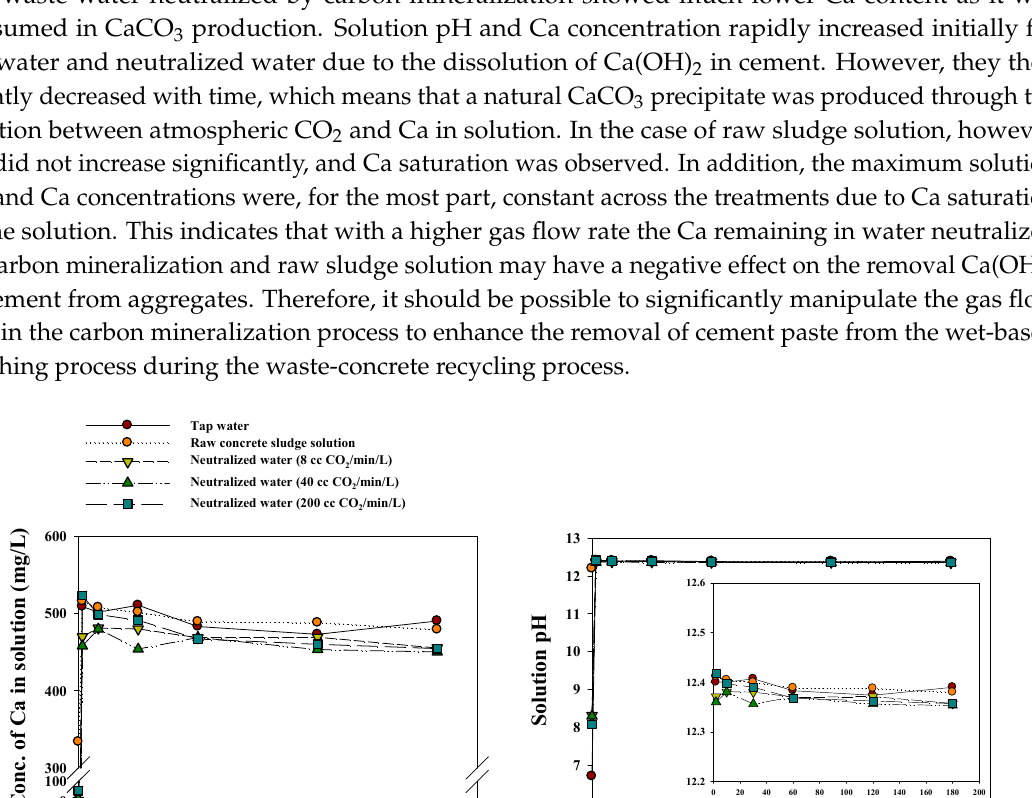
Figure 9. ( a – c ) The SEM images of CaCO 3 particles precipitated through the carbon mineralization processes (8, 40 and 200 cc CO 2 /min/L).